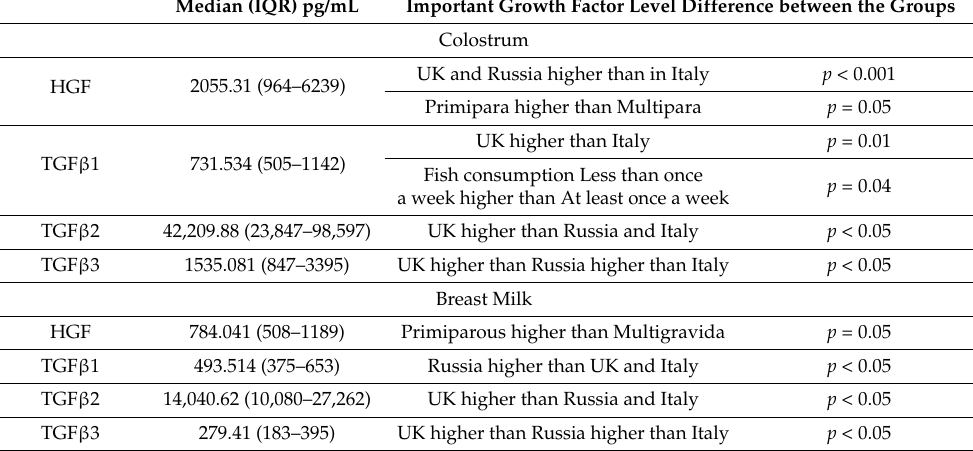
Table 3. Concentration (pg/mL) of growth factors in colostrum and breast milk and exposures associated with the levels.